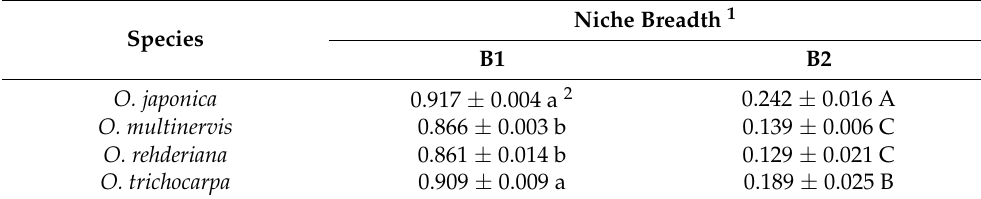
Table 3. Niche breadth (mean ± SE) of four Ostrya species estimated by ENMTools [79].